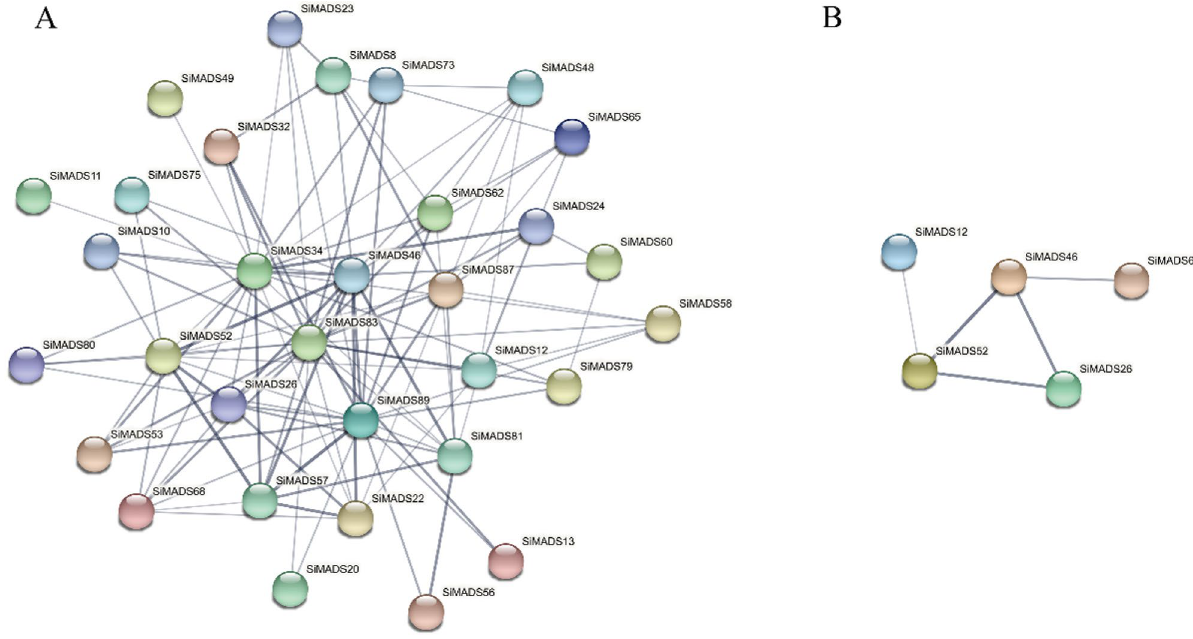
Figure 3. Predicted interactions between foxtail millet MADS-box proteins. ( A ) Prediction of the protein– protein interaction network among 89 SiMADS. ( B ) Prediction of the protein–protein interaction network among 5 SiMADS in stress